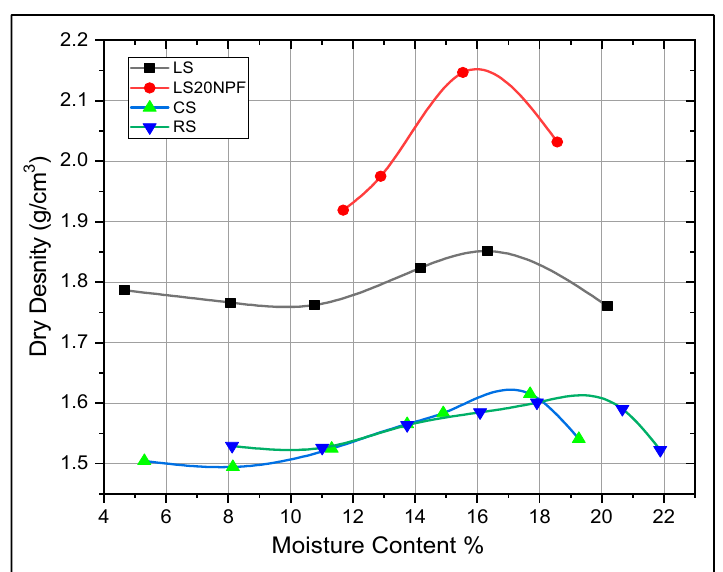
Figure 2. Standard Proctor test results.